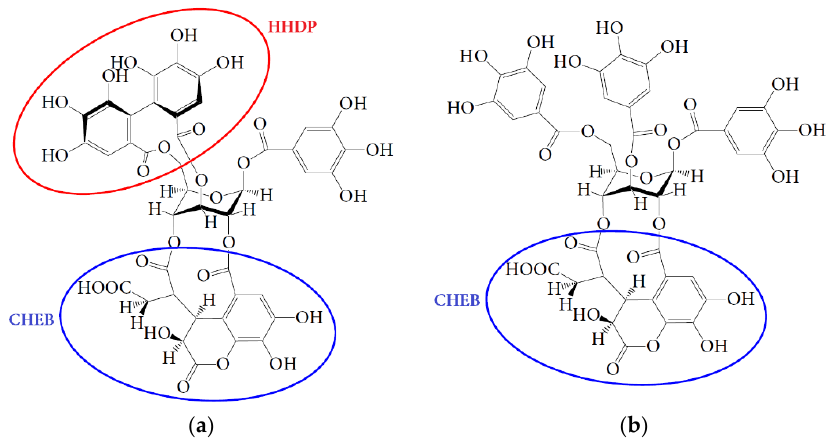
Figure 9. Structures of chebulagic acid ( a ) and chebulinic acid ( b ) (according [18]). Circles are framed hexahydrodiphenoyl (HHDP) and chebuloyl (CHEB) moieties.